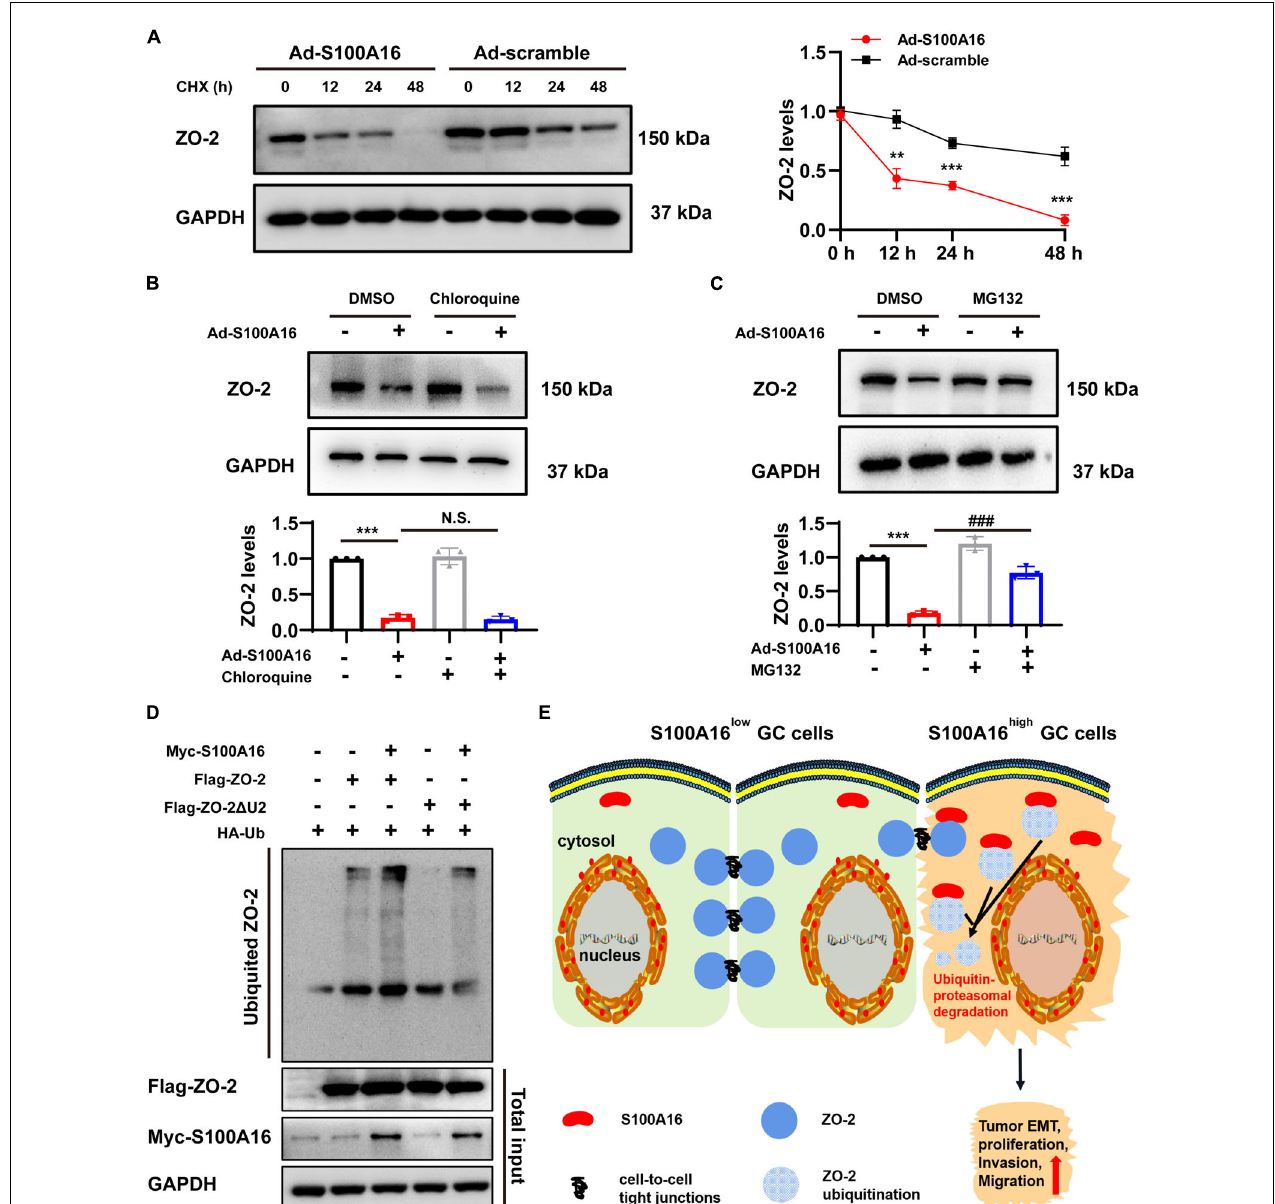
FIGURE 8 | S100A16 contributes to ZO-2 ubiquitination and degradation. (A) SGC-7901 cells were transfected with Ad-S100A16 or Ad-control for 6 h. After co-culture with 50 mmol/l cycloheximide (CHX) for 0, 12, 24, or 48 h, Western blot analysis was performed, and the relative ZO-2 expression was calculated on the right. (B) SGC-7901 cells were transfected with Ad-control or Ad-S100A16 for 6 h and then treated with or without chloroquine (50 µ mol/l) for another 48 h; ZO-2 expression was measured through Western blot analysis. (C) SGC-7901 cells were transfected with Ad-control or Ad-S100A16 for 6 h and then treated with or without MG132 (10 µ mol/l) for another 48 h; ZO-2 expression was measured through Western blot analysis. (D) SGC-7901 cells were co-transfected with Ub-HA, S100A16-Myc, and ZO-2-Flag or ZO-2- (cid:49) U2 region-Flag expression plasmids for 18 h; 6 h after treatment with proteasome inhibitor MG132 (10 µ mol/l), the cells were lysed, and the supernatant was collected for an IP experiment. Flag-Tag antibody was used for immunoprecipitation, and HA-Tag antibody was used for Western blot analysis to measure the level of exogenous ZO-2 ubiquitination. (E) A proposed model of S100A16 mediating ZO-2 inhibition via ubiquitin-proteasomal degradation in GC metastasis. Data are presented as mean ± SD. N = 3 for each group. For panels (A–C) , ** P < 0.01, and *** P < 0.001 vs. Ad-scramble group, ### P < 0.001 vs. Ad-S100A16